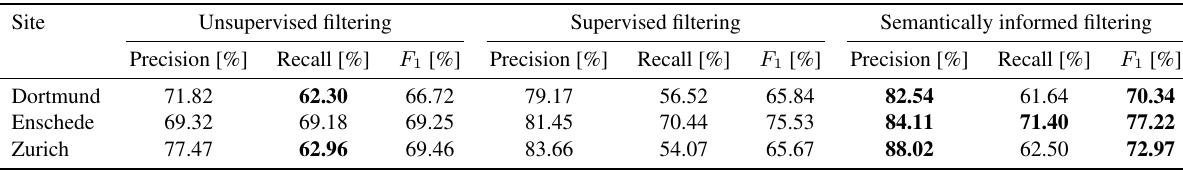
Table 1: Quantitative results (average numbers after 6-fold cross-validation) of the supervised, non-semantic filtering approach and the semantically informed filtering approach in comparison with the heuristic, unsupervised filtering approach of (Sotoodeh, 2006).